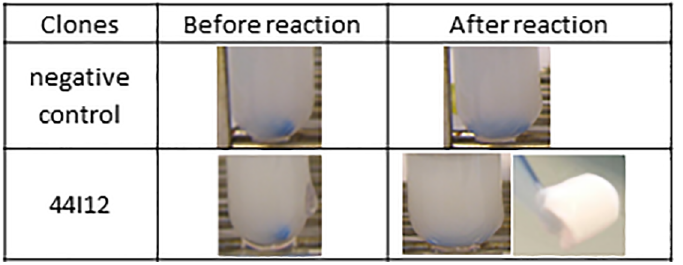
Fig 1. Reaction media of 44I12 cytoplasmic extract incubated with Impranil at 30˚C and pH 7.0 during 24h. Negativecontrol: E . coli host strain Epi100transformed with the empty pCC1FOS fosmid. For 44I12, the reactionmedium, in and out of the tube, is showed, since a solid aggregatecould be obtained.